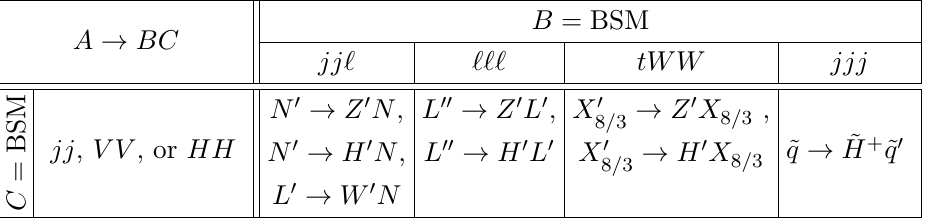
Table 7 . Example (Group VII in table 1) for A ! BC , where A , B and C are BSM particles. The C decays to two similar SM particles, while the B decays to more complex (cid:12)nal states. The jj denotes a diquark with all possible (cid:13)avor combinations, and V V includes (cid:13)(cid:13) , (cid:13)Z , ZZ , or WW . The N denotes a right-handed heavy neutrino which decays to N ! W 0 ( (cid:3) ) ‘ ! jj‘ . The L 0 represents a generic vector-like lepton decaying to L 0 ! Z 0 ( (cid:3) ) ‘ ! ‘‘‘ .